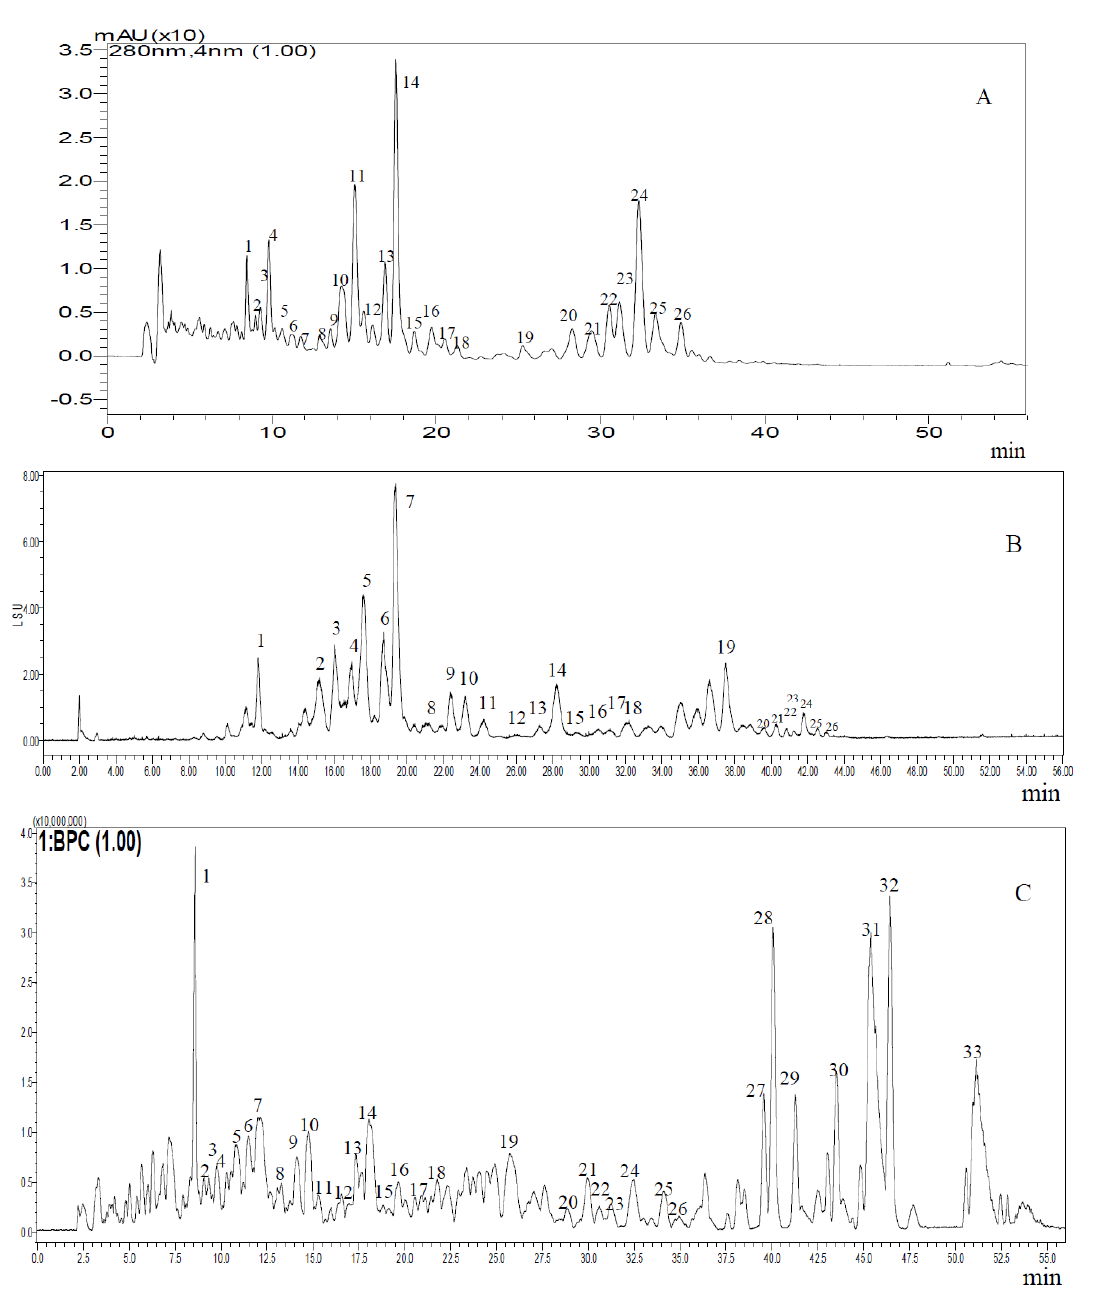
Figure 2. Typical chromatograms of saponins in tea seed pomace ( C. oleifera ). ( A ) Chromatogram at UV 280 nm (LC/UV); ( B ) Chromatogram at ELSD (LC/ELSD); ( C ) Total ion chromatogram